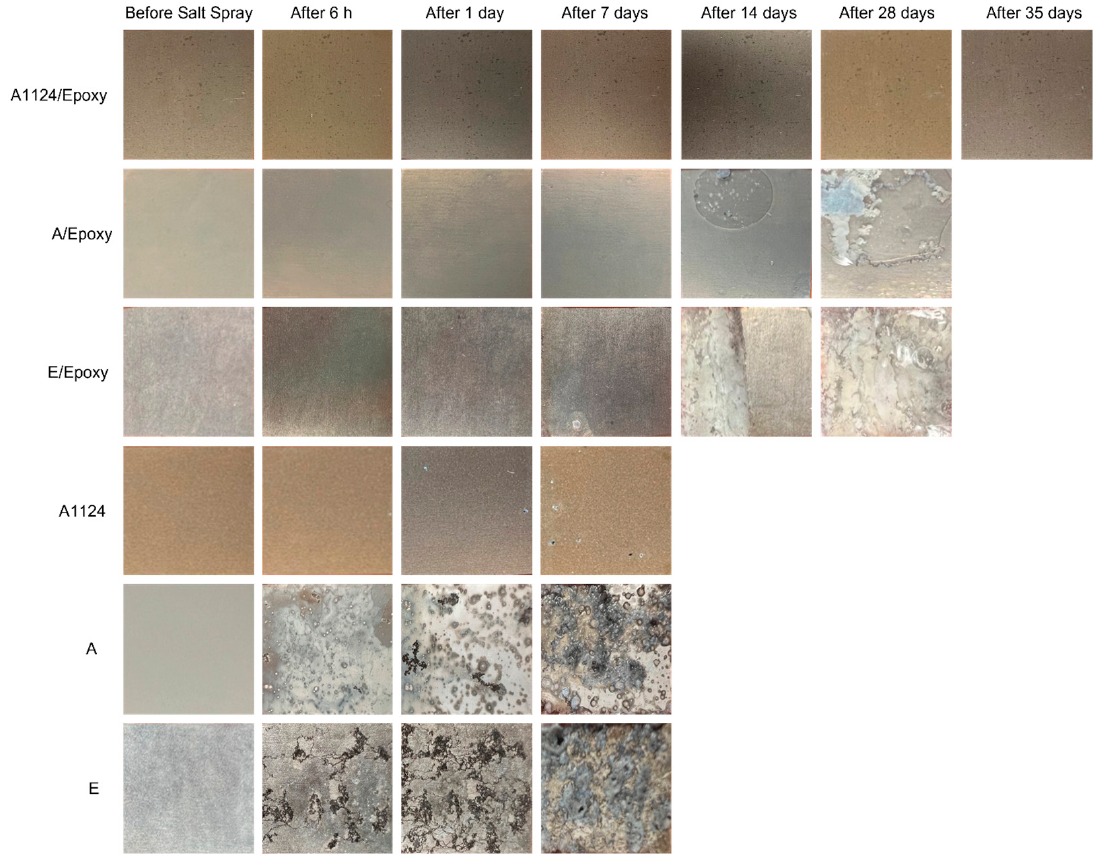
Figure 15. Macroscopic images of the intact samples after salt spray test.